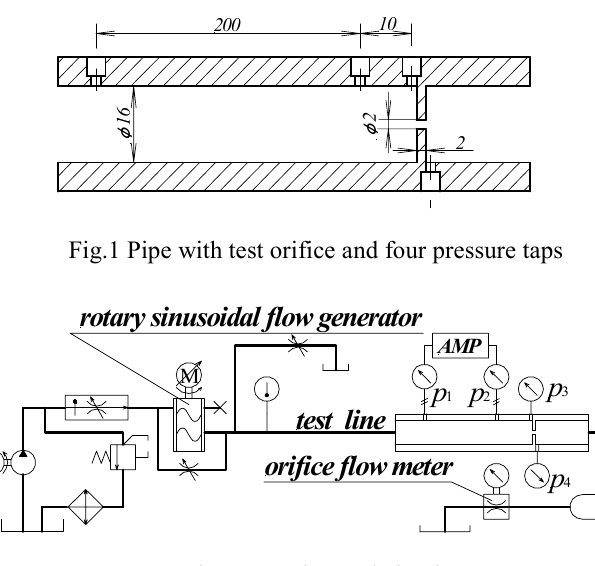
Fig.2 Experimental